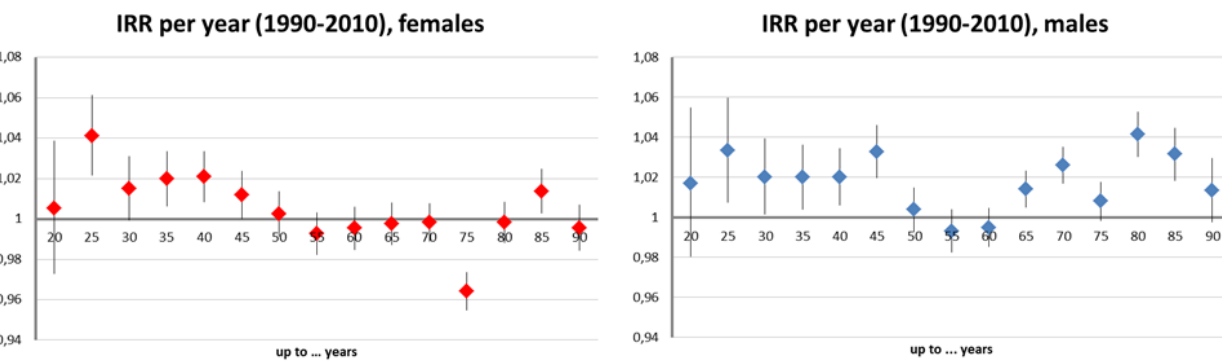
Figure 3. Age-group specific melanoma incidence risk ratios (IRR) and 95% confidence intervals (CI) per year (1990-2010): Raw incidence data controlled for altitude, urban and “Styrian” factors, and offset by the same year population number of the very group; females (left), males